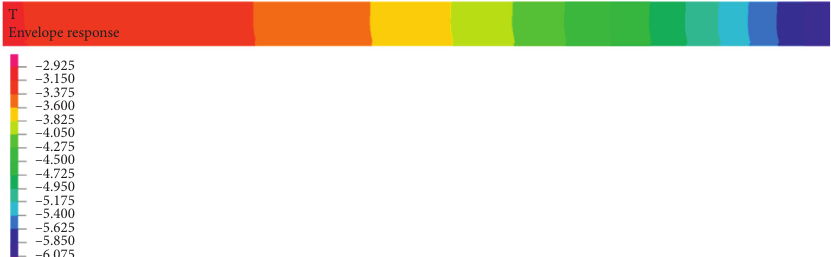
Figure 30: Annual average air temperature distribution in the tunnel axis at an air velocity of 3.0m/s.